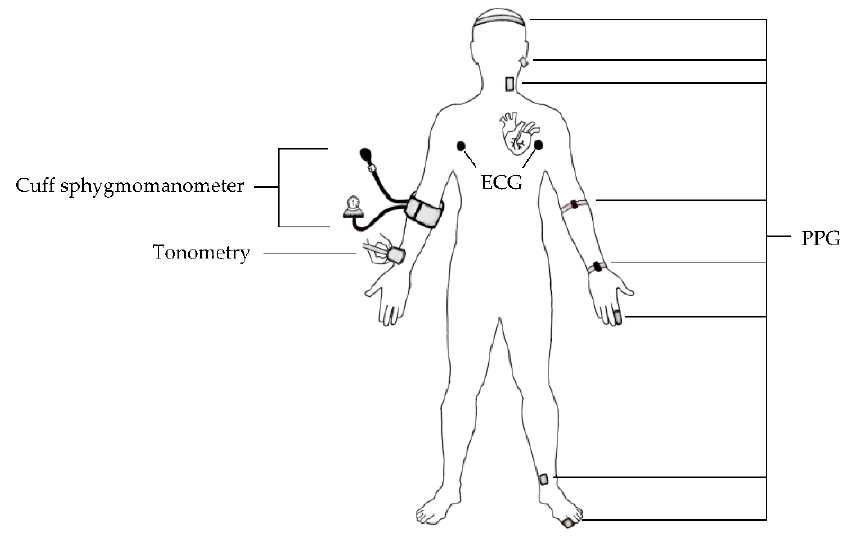
Figure 1. Overview of the current NIBP sensors.